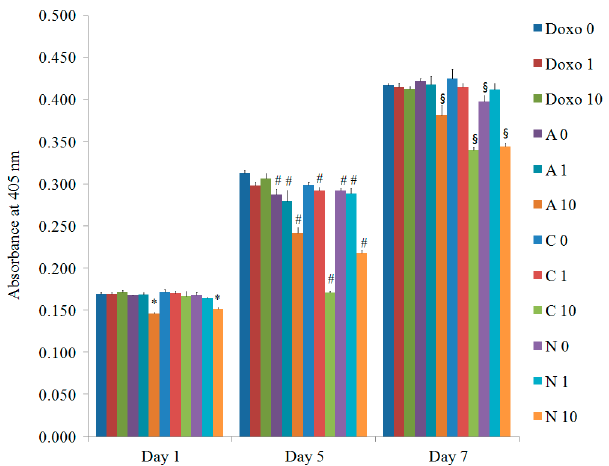
Figure 4. The alkaline phosphatase activity on Days 1, 5, and 7. * Statistically significant di ff erences were noted when compared with the data from the doxorubicin 0 µ g / mL (Doxo0) group on Day 1 ( p = 0.015). # Statistically significant di ff erences were noted when compared with the data from the doxorubicin 0 µ g / mL (Doxo0) group on Day 5 ( p = 0.001). § Statistically significant di ff erences were noted when compared with the data from the doxorubicin 0 µ g / mL (Doxo0) group on Day 7 ( p = 0.003).